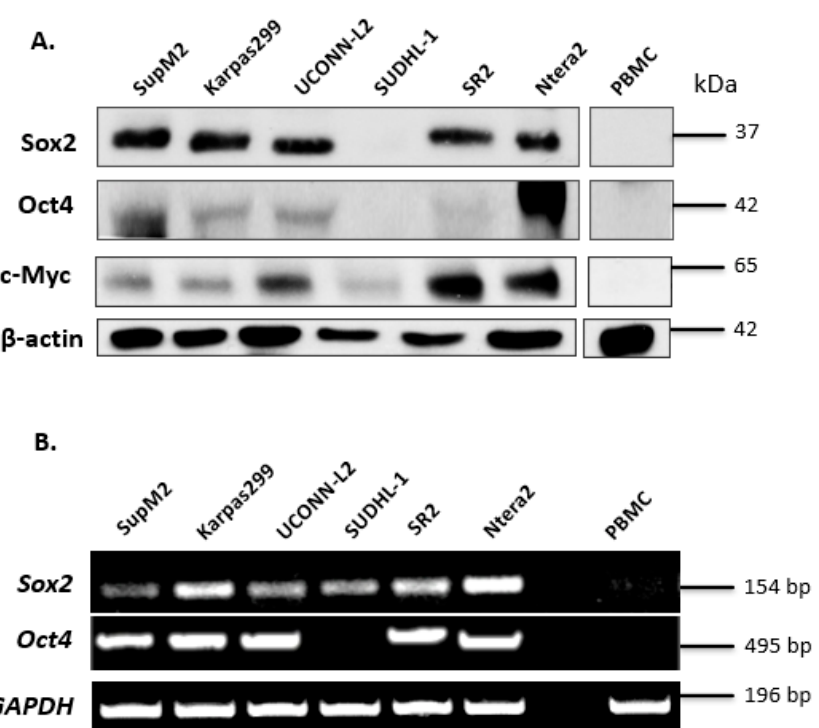
Figure 1. Expression of iPS factors in ALK + ALCL cells. ( A ) Western blotting analysis of the iPS factors (Sox2, Oct,4 and c-Myc) in a panel of 5 ALK + ALCL cell lines. Ntera-2 cells were used as a positive control for Oct4. PBMC was used as a negative control. ( B ) Sox2 and Oct4 mRNA expression in five ALK + ALCL cell lines; Ntera-2 and PBMC were measured by PCR.